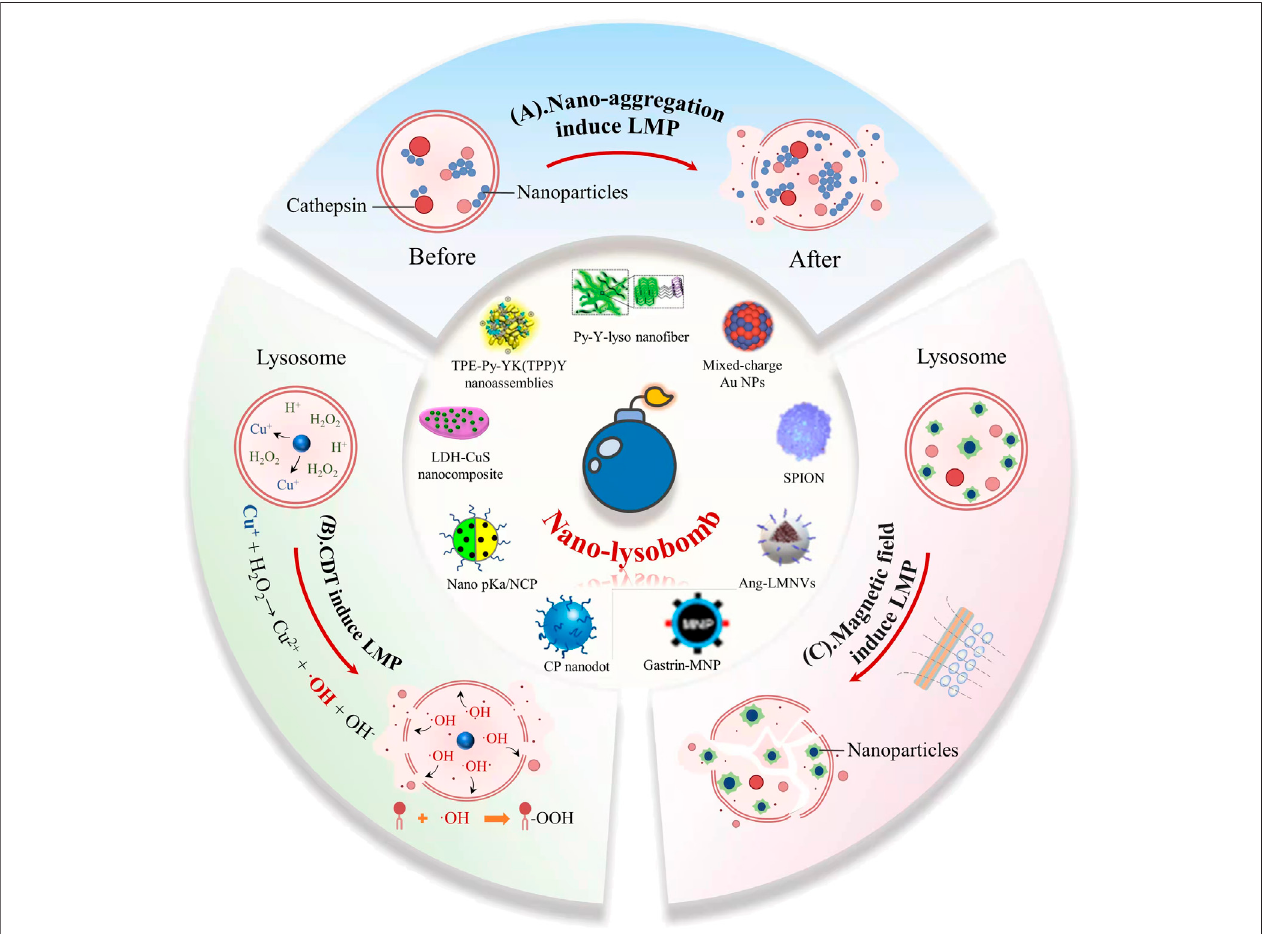
FIGURE 1 | Schematic illustration of nano-lysobombs inducing LMP and lysosome cell death. Nano-lysobombs are classi fi ed into three groups according to their action mechanism: nano-aggregation, CDT process, and magnetic fi eld induction (A) The fi rst class of nanodrugs triggers osmotic fl ow and lysosome swelling by self- assemblingonthecell membrane or aggregating inlysosomes (B) Thesecondclassofnanodrugs triggerstheFenton reaction inthelysosomes,using generatedOHto induce lipid peroxidation (LPO) of the lysosomal membrane and then trigger LMP (C) The third class uses the thermal effects or mechanical stress generated by magnetic fi eld-stimulated magnetic nanoparticles to destroy the lysosomal membranes, eventually killing the cells.